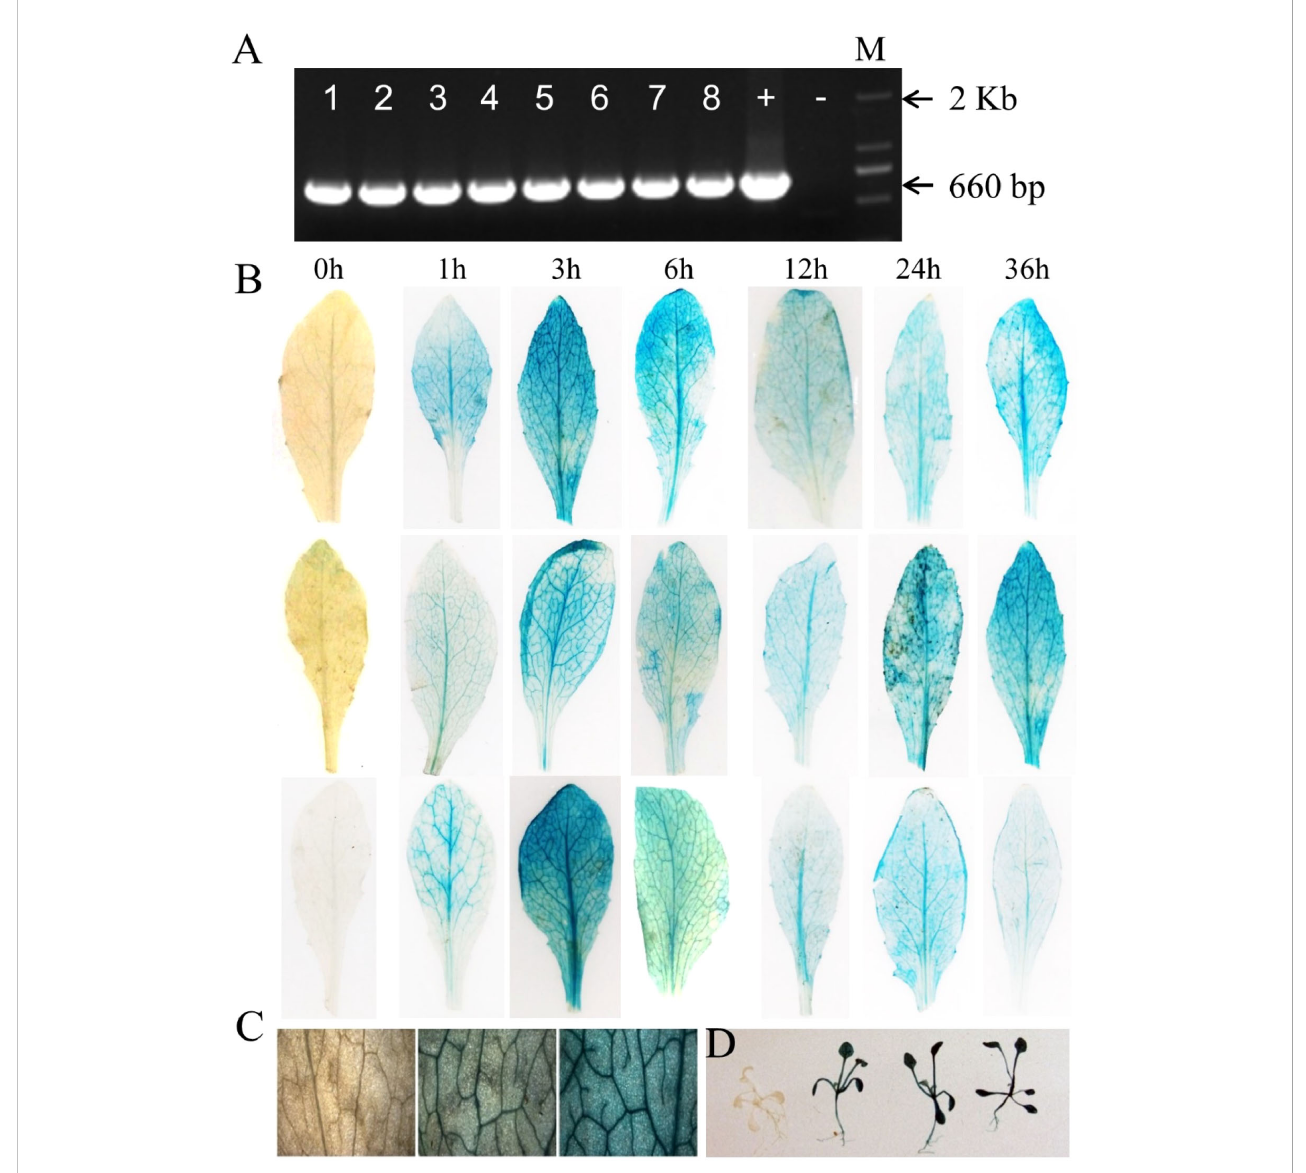
FIGURE 6 Evaluation of the function of AhOMT1 promoter. (A) Con fi rmation of transgenic Arabidopsis plants with AhOMT1P (660bp fragment) PCR ampli fi cation with promoter-speci fi c forward and GUS gene speci fi c reverse primers pair. Arabidopsis Col-0 was used as negative control, and Gateway LR constructs used as positive control. M shows 2kb marker. (B) Strong GUS staining of AhOMT1P transgenic leaves is only induced by A. fl avus infection with spores after 1 h of infection. GUS gene was not active in non-treated leaves. GUS staining was present in leaf samples at all time points after inoculation. (C) Magni fi ed leaf surface staining indicated that AhOMT1P activated the GUS gene expression after infection with A. fl avus spores. (D) Transgenic seedlings showing deep GUS staining only after A. fl avus